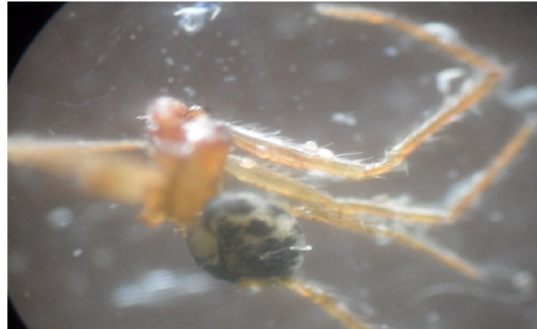
Fig. 7. Lepidocyrtus cyaneus (Silver springtail), with visible furcular